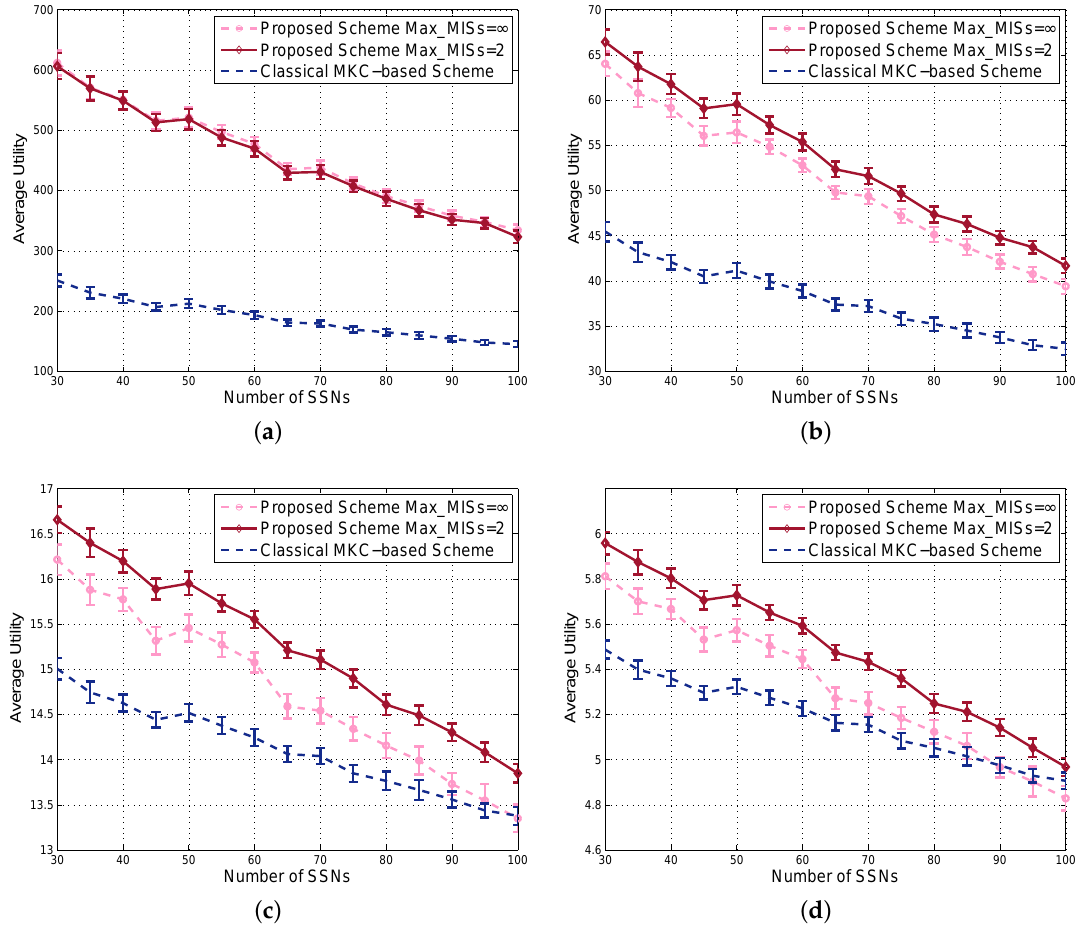
Figure 9. Comparison of utility in dense scenarios: ( a ) α = 0; ( b ) α = 0.4; ( c ) α = 0.8; ( d ) α =